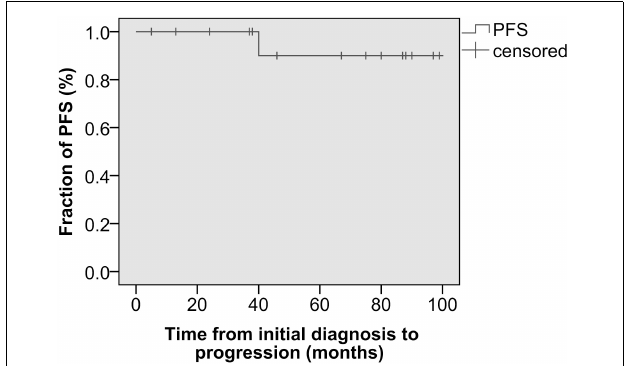
FIGURE 2 | Progression-free survival curve—the time from the initial diagnosis to